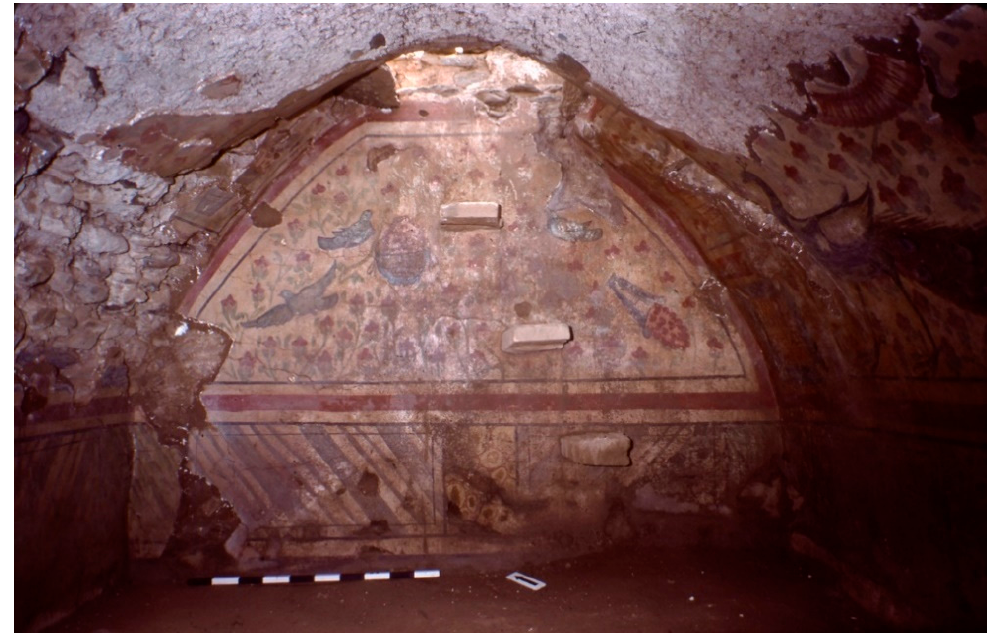
Figure 3. Sardis, Tomb of Chrysanthios (Tomb 76.1, Appendix A.1), north wall with offset cantilevered steps and vault entrance above. © Archaeological Exploration of Sardis/President and fellows of Harvard College.